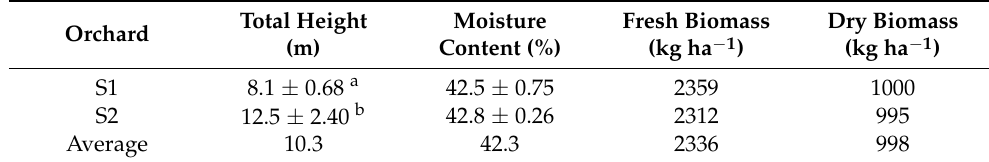
Table 2. Total height, moisture content and biomass yield in walnut trees grown in two orchards established in Durango, M é